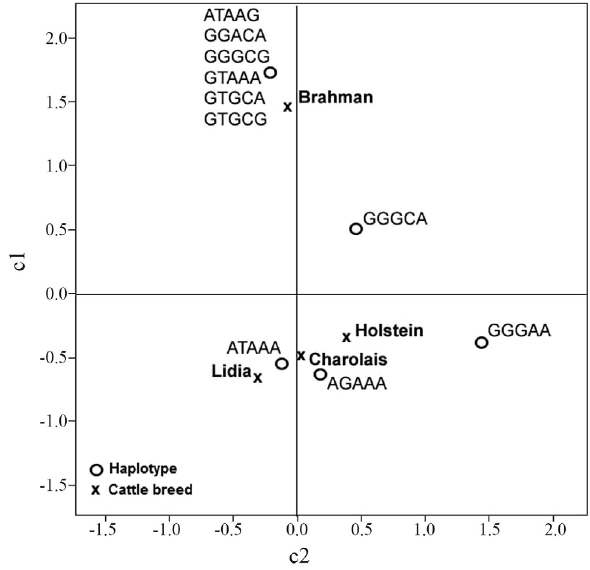
Figure 1 - Correspondence analysis showing the DBH haplotypes diver- sity observed in four cattle breeds with different genetic